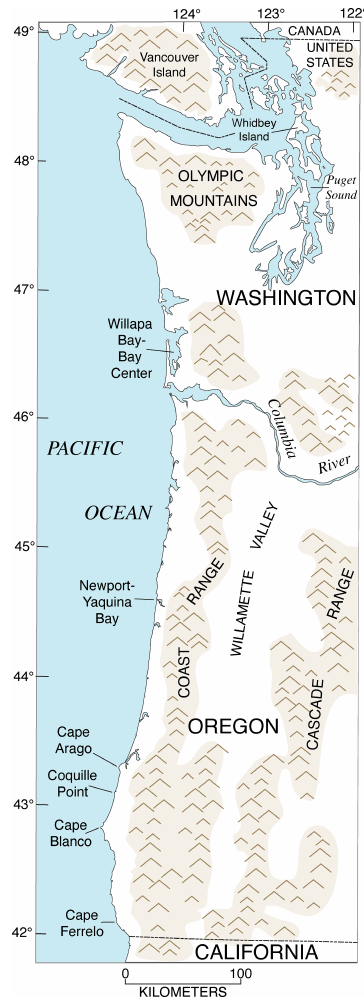
Figure 16. Map of southwestern Canada, Washington, and Oregon, showing physical geography (shaded areas are mountain ranges) and localities referred to in the text. Redrawn in simplified form from U.S. Geological Survey (public domain) base maps of Wash- ington (1982), scale 1 : 500000, and Oregon (1982), scale 1 :